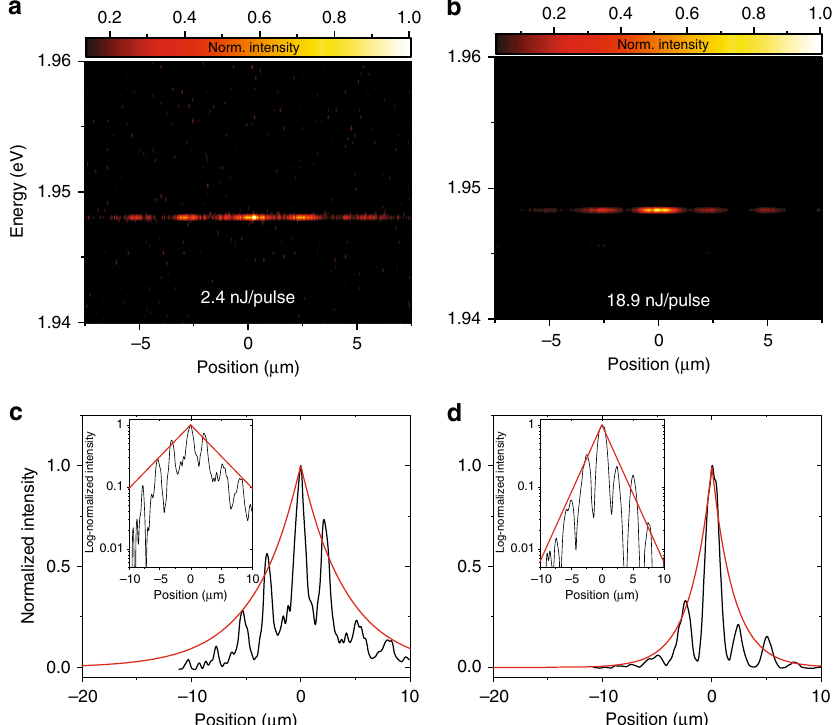
Fig. 4 Self-localization of a gap-solitonic mode. a , b Energy-resolved real-space images under on-site pumping conditions little above threshold ( a P = 2.4 nJ/pulse) and far above threshold ( b P = 18.9 nJ/pulse). c , d The intensity traces (black) are fi tted by an exponential function (red). Narrowing of the spatial extension of the condensate from 7.0 ± 0.8 μ m slightly above threshold to 3.6 ± 0.5 μ m at approximately one order of magnitude above threshold characterizes the gap state. In the insets, the same pro fi les are shown in log de fl ected through a beam splitter and overlaid itself with a retrore fl ector and a mirror (further details can be found in Supplementary Notes 8 and 9). Numerical modeling . For numerical calculations of the polariton dynamics in organic lattices, we considered a two-dimensional mean- fi eld model, which has been widely used for simulation of inorganic semiconductor cavities 37,38 , and very recently for organic systems 39 . This model consists of the open-dissipative Gross – Pitaevskii equation for the condensate wavefunction incorporating sto- chastic fl uctuations and coupled to the rate equation for the excitonic reservoir created by the off-resonant pump 30,38 . In particular, our theoretical analysis con fi rms that the gap state bifurcates from the upper edge of the band characterized by the “ staggered ” phase, and therefore inherits the characteristic π -phase shift between neighboring density peaks 36 . For further details on numerical modeling, we refer to Supplementary Note 5.